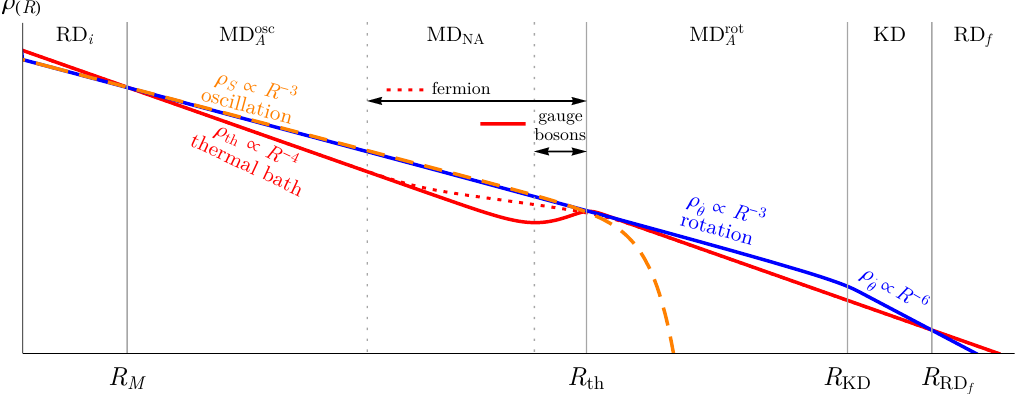
Figure 9 . Evolution of various energy densities as functions of the scale factor R for the quadratic potential. The red, orange dashed, and blue curves are respectively the energy densities of the thermal bath, the oscillation (saxion), and the rotation (axion). The red solid and dotted curves distinguish the different thermalization channels– scattering with the fermion and the gluon. The vertical lines separate different cosmological eras: R M the beginning of matter domination MD, R th the completion of thermalization, R KD the beginning of kination domination KD, and R RD the beginning of final radiation domination RD f